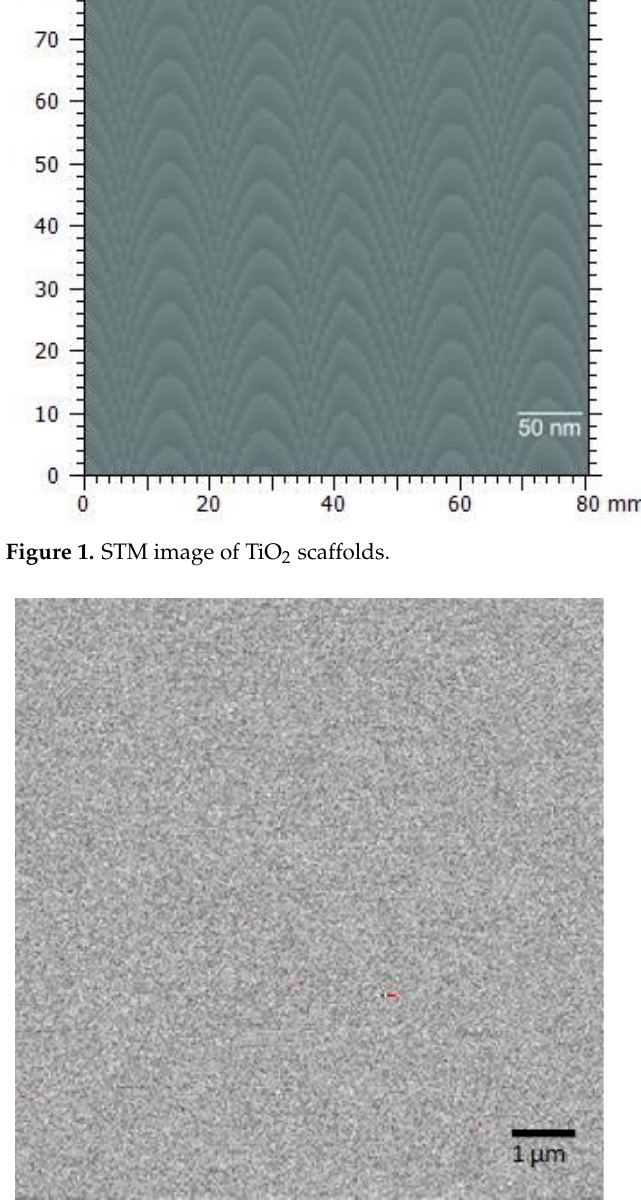
Figure 2. Microstructural analysis of TiO 2 scaffolds.